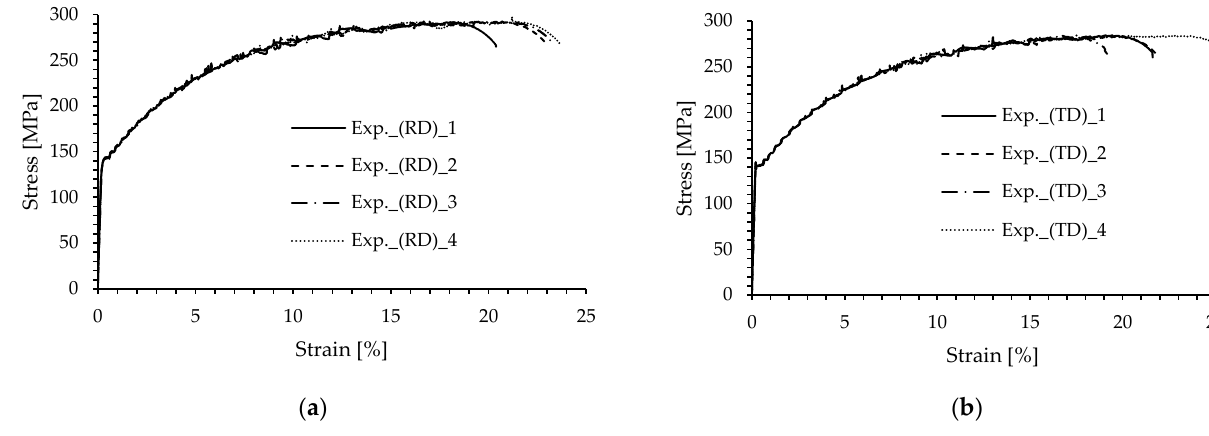
Figure 4. Engineering stress – strain curves of the AA 5083-H111 alloy. ( a ) Rolling direction (RD). ( b ) Transverse direction (TD). Table 2. Average mechanical properties of AA 5083-H111.